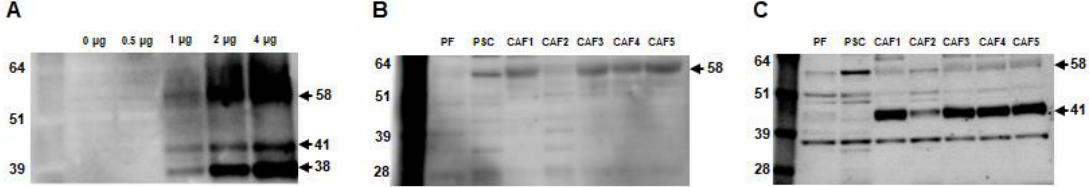
Figure 1. Immunoblotting of GPR68. ( A ) HEK293 cells were transfected with GPR68-v5tag plasmid (0–4 µg). After 48 h, cell lysates were prepared for immunoblotting using V5 antibody (#R960-25,